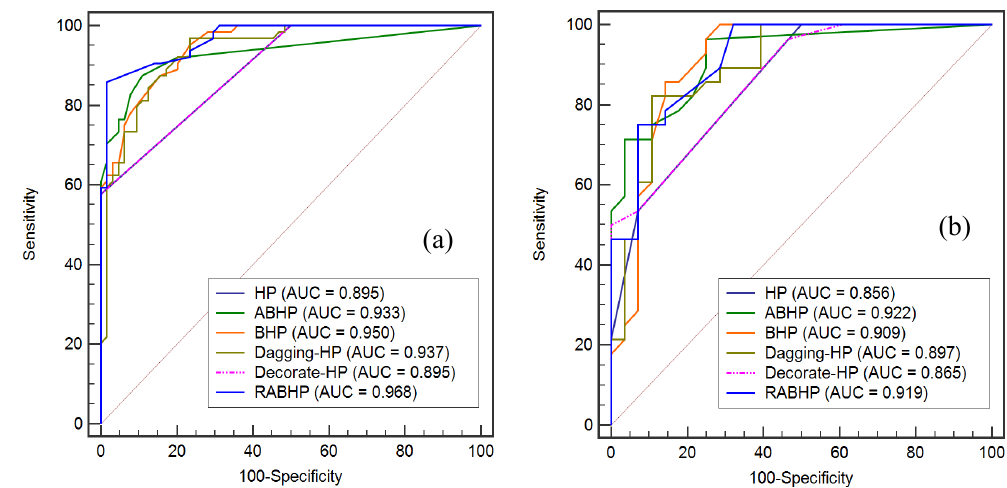
Figure 6. The AUC values derived from the models over ( a ) the training phase and ( b ) the validation phase.